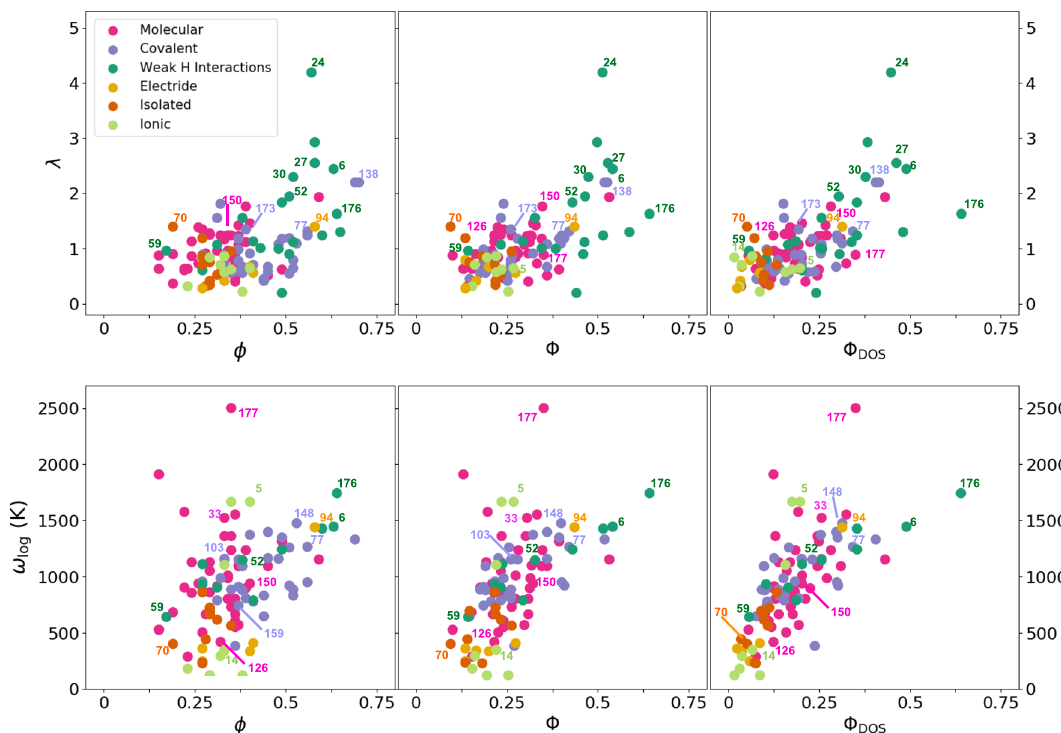
Fig. 5 Networking value with respect to λ and ω log . The fi gure shows, respectively, λ and ω log as a function of the networking value ( ϕ ), the reduced networking value ( Φ ), and the reduced networking value corrected by the hydrogen contribution to the DOS at the Fermi energy ( Φ DOS